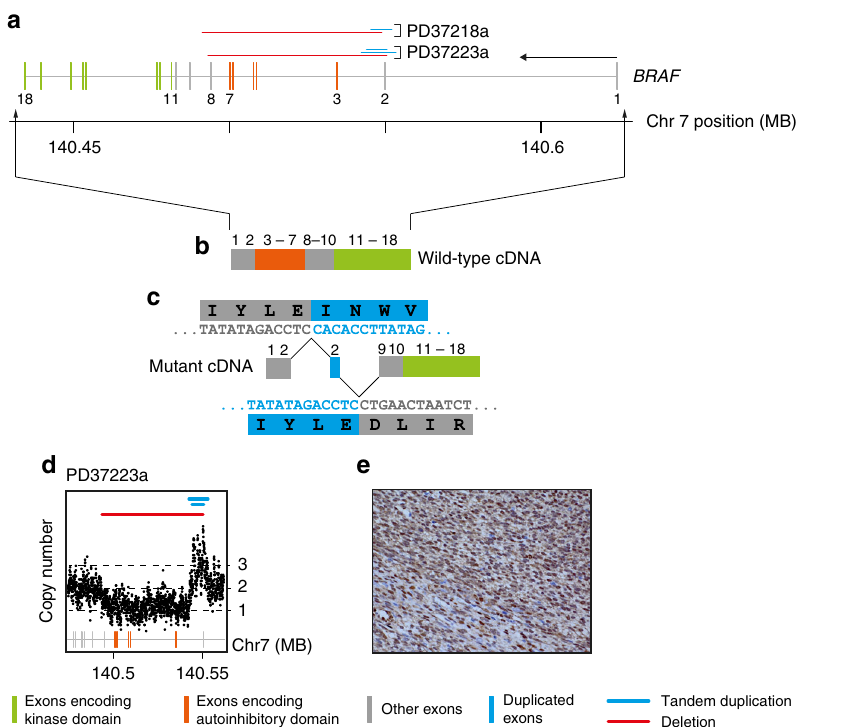
Fig. 2 Internal BRAF deletion. a The genomic footprint of BRAF is depicted with exons represented by gray, green, and orange vertical lines. Green and orange exons encode the kinase domain and conserved region 1, respectively. Horizontal lines above exons demarcate rearrangements (blue: tandem duplication; red: deletion). b Outline of wild-type transcript. c Outline of fusion transcript with cDNA sequence of rearrangements (sense orientation) with translation. d Intragenic copy number of BRAF ( x -axis: genomic coordinate; y -axis: copy number derived from coverage). e Representative